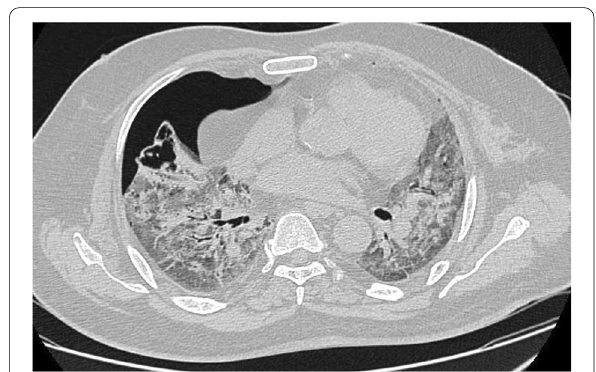
Fig. 4 Axial HRCT scan of a 52-year-old male revealed pneumothorax on the right side. A cavitary lesion with irregular margins and few internal septations was detected in the right middle lobe, indicating the likelihood of a fungal infection within the cavity. A culture test revealed that the patient had candidiasis. Mechanical ventilation was the cause of the pneumothorax. Cavity formation might be caused by invasive candidiasis, mechanical ventilation, or a combination of the